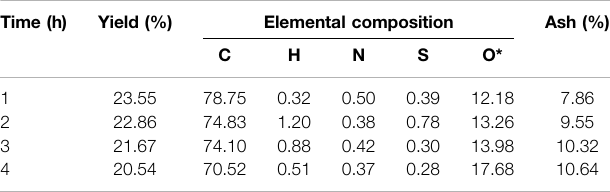
*Oxygen content determined by difference.